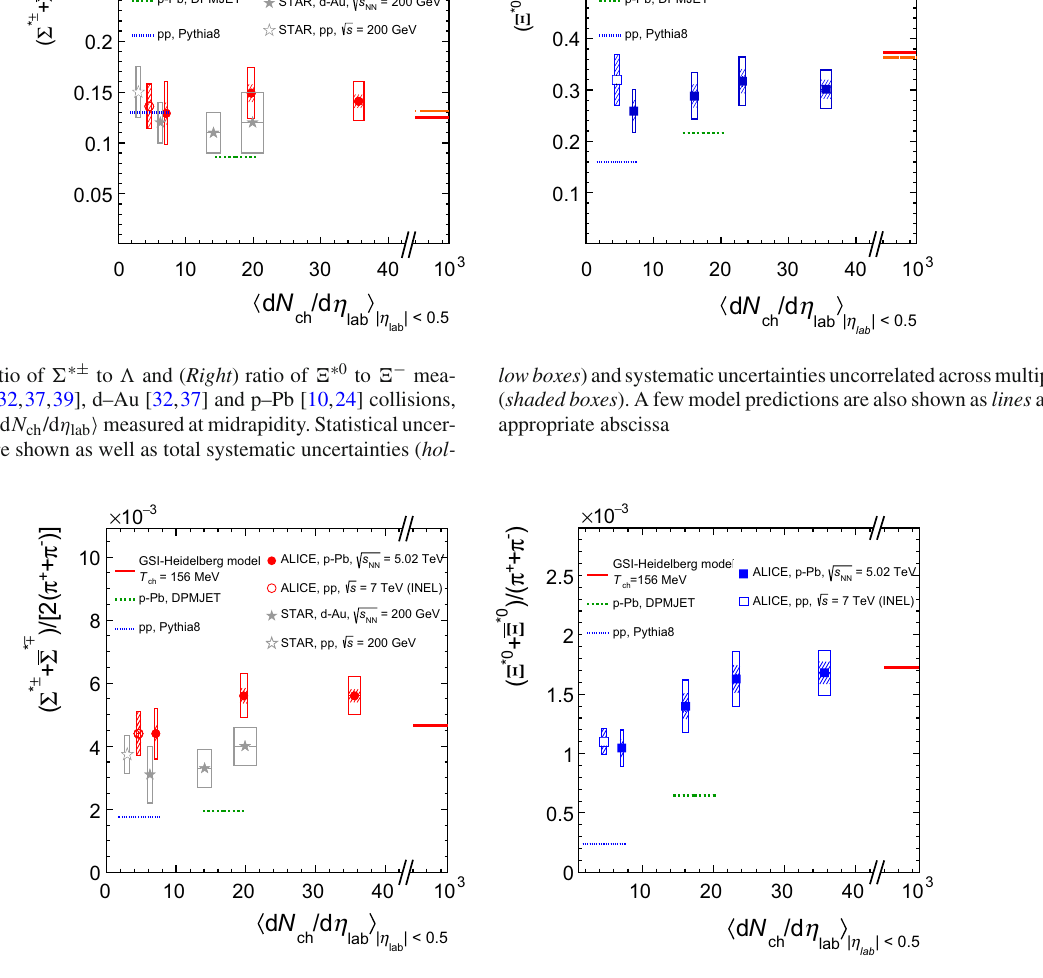
at ALICE [10]. The constant behavior of the (cid:3) ∗± / (cid:9) and (cid:4) ∗ 0 /(cid:4) − ratios indicates that the strangeness